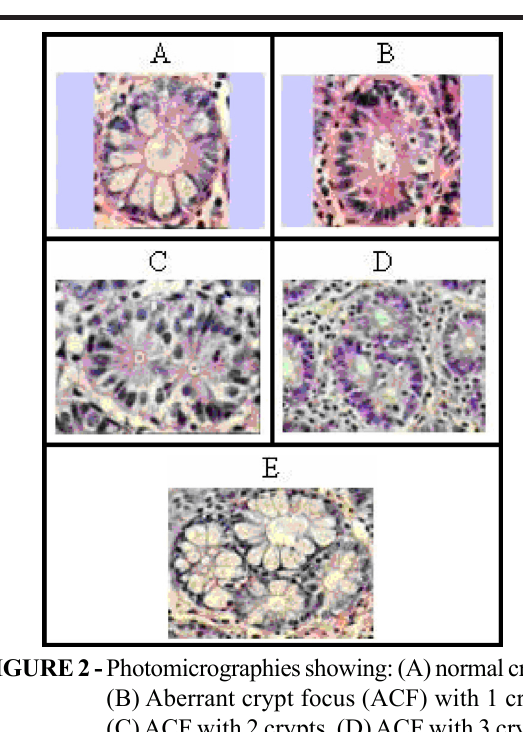
FIGURE 2 - Photomicrographies showing: (A) normal crypt,